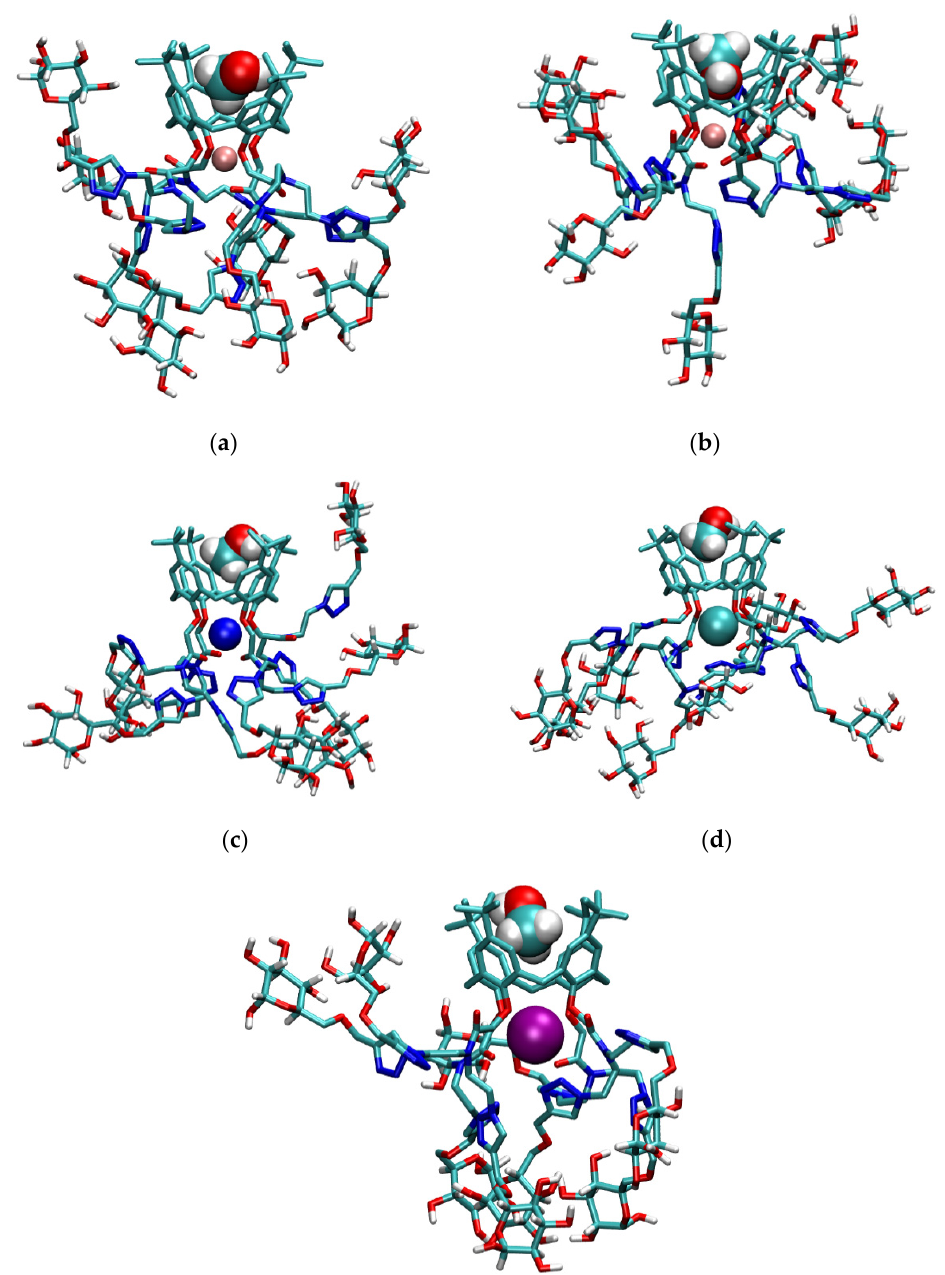
Figure 9. Structures of ( a ) Li l MeOH + ; ( b ) Li l MeOH' + ; ( c ) Na l MeOH + ; ( d ) K l MeOH + ; and ( e ) Rb l MeOH + adducts obtained by MD simulations at 25 °C. Non-glucose hydrogen atoms of l are omitted for clarity.